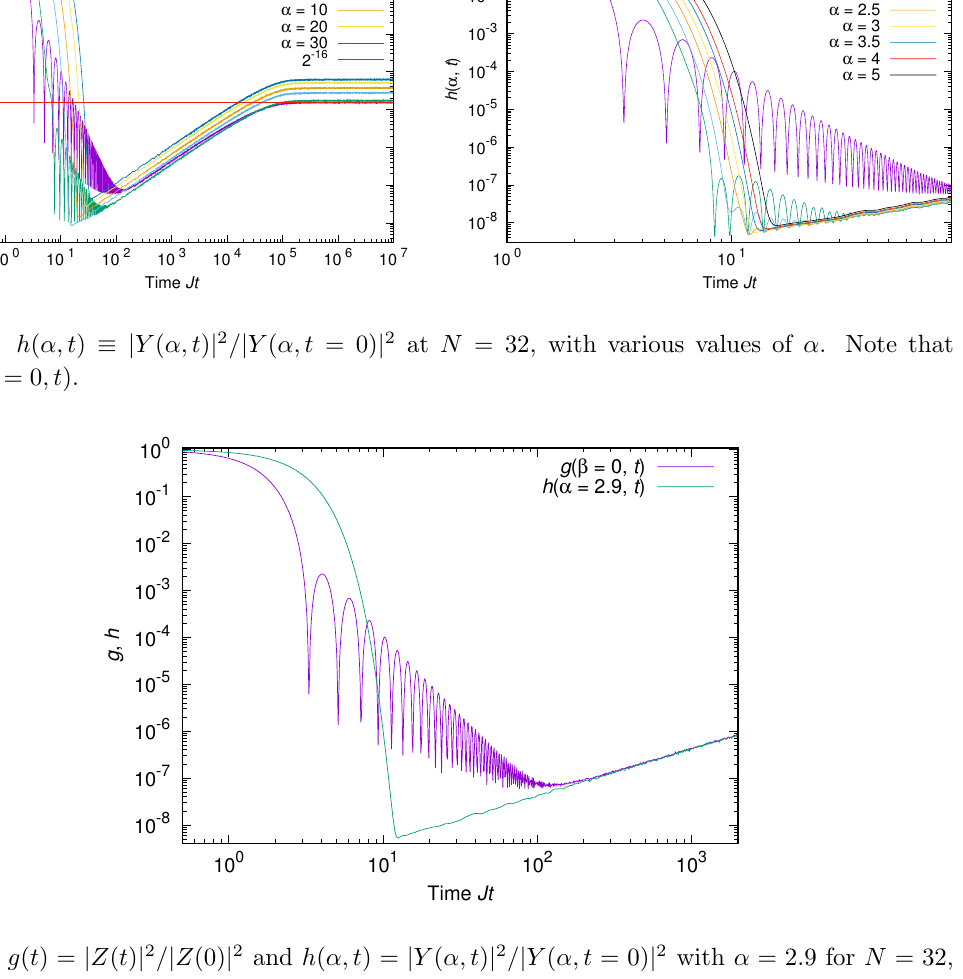
Figure 4 . g ( t ) = j Z ( t ) j 2 = j Z (0) j 2 and h ( (cid:11); t ) = j Y ( (cid:11); t ) j 2 = j Y ( (cid:11); t = 0) j 2 with (cid:11) = 2 : 9 for N = 32, 1500